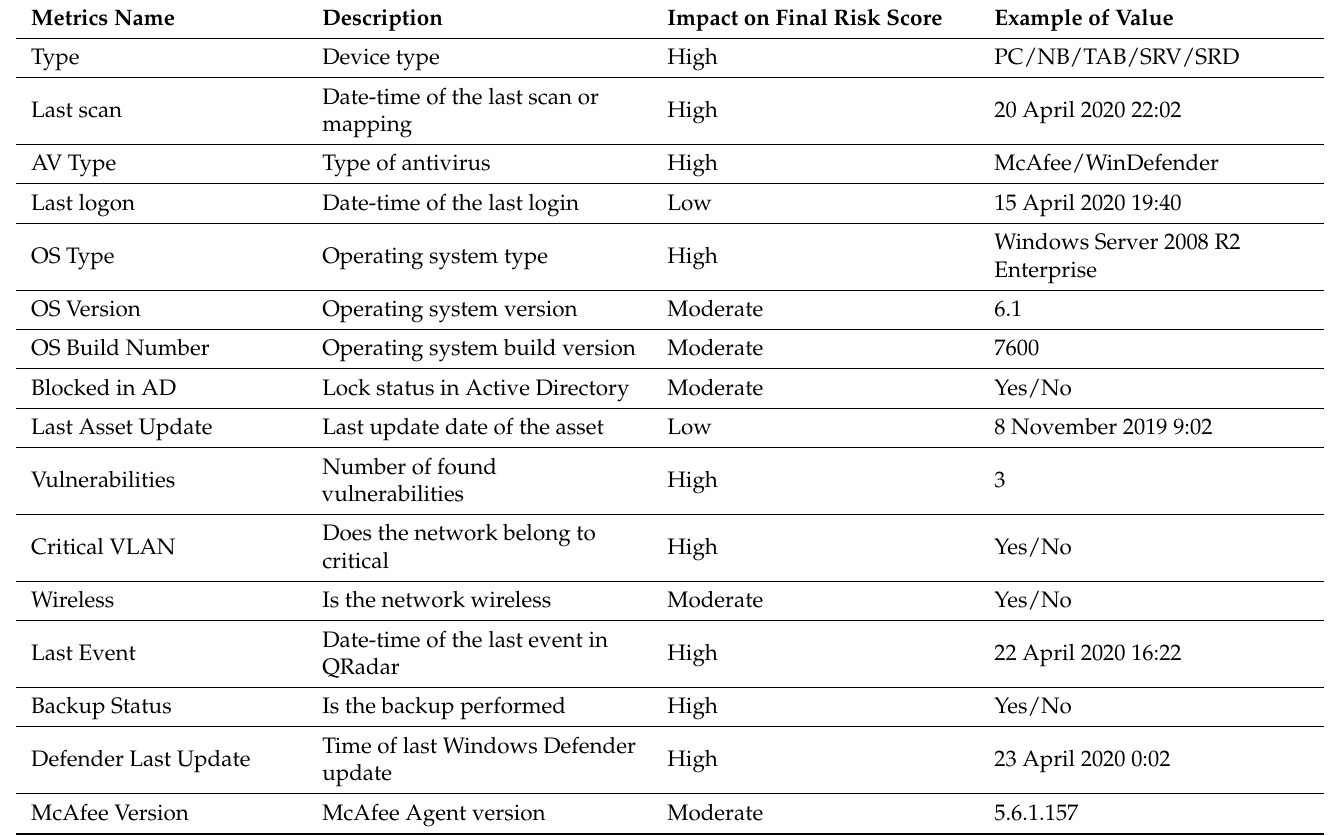
Table 2. Example of distributed metadata and asset